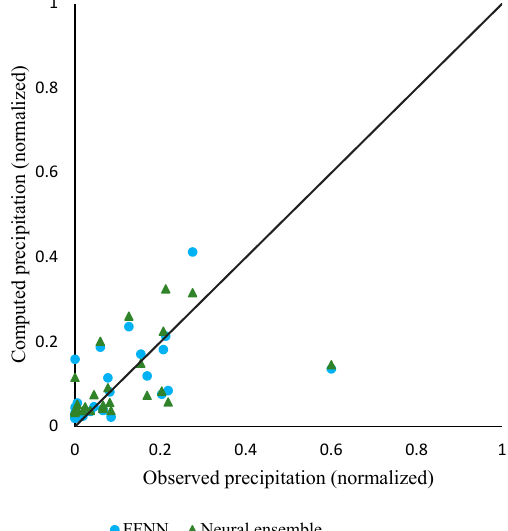
Figure 13. Scatter plot for verification step using FFNN and neural ensemble method based on scenario 2 for Girne station.